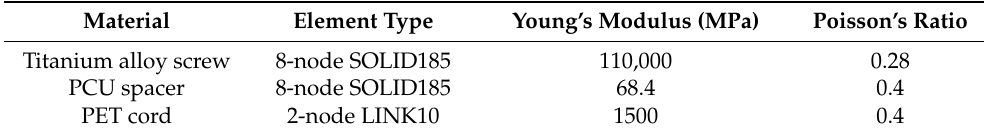
Table 1. Material parameters of the Dynesys system.